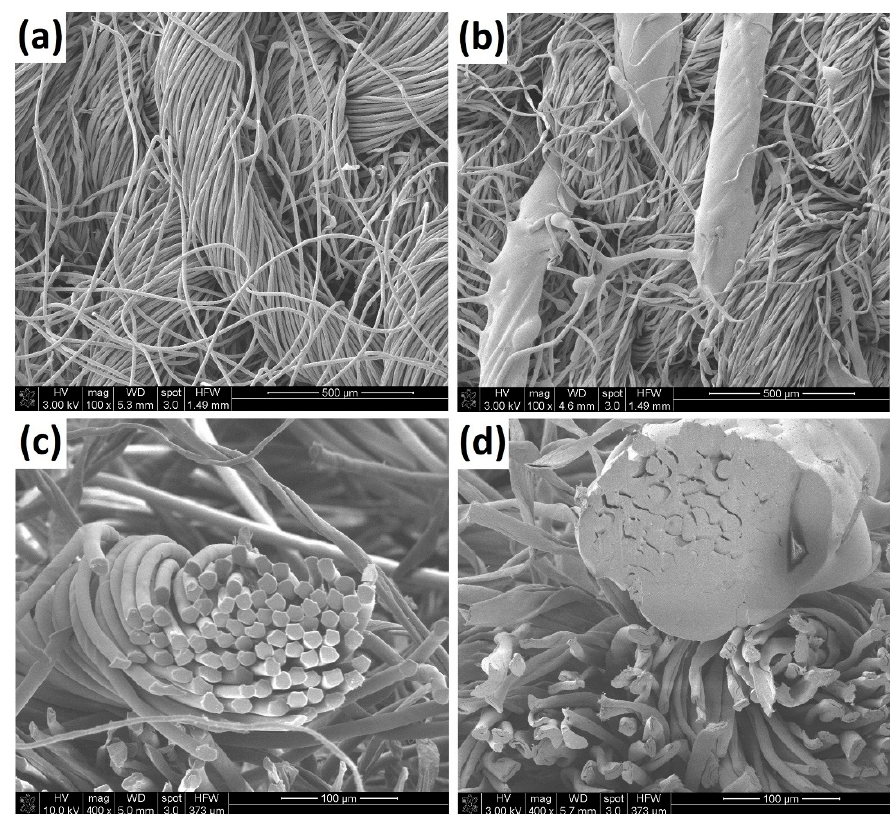
Figure 1. SEM images of Sample 1 (CO 83/PES 17): Knitted fabric surface (magnification 100×) ( a ) before exposure and ( b ) after radiant heat exposure (10 kW·m − 2 , 30 s); cross-section of yarn (magnification 400×) ( c ) before exposure and ( d ) after radiant heat exposure (10 kW·m − 2 , 30 s).